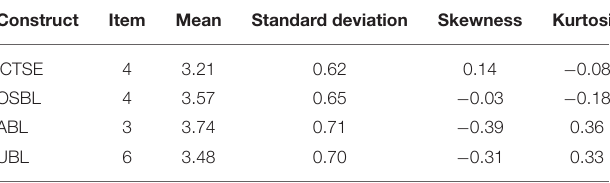
TABLE 2 | Descriptive statistics of the study constructs.